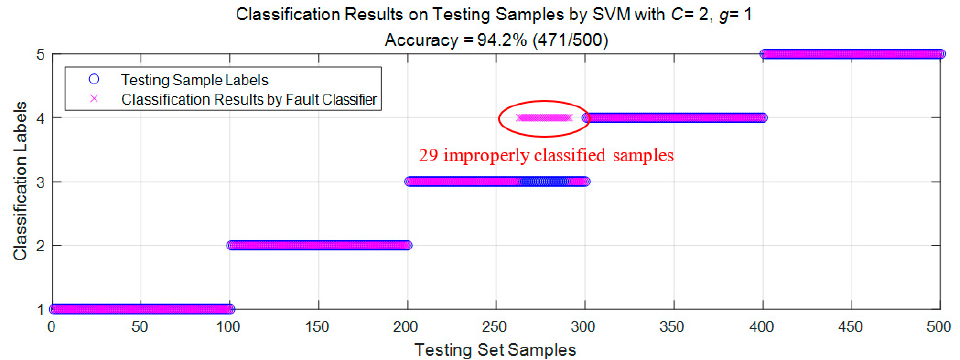
Figure 18. Fault classification results on testing set by SVM with assigned parameters C = 2 and g = 1 (classification accuracy = 94.2%).